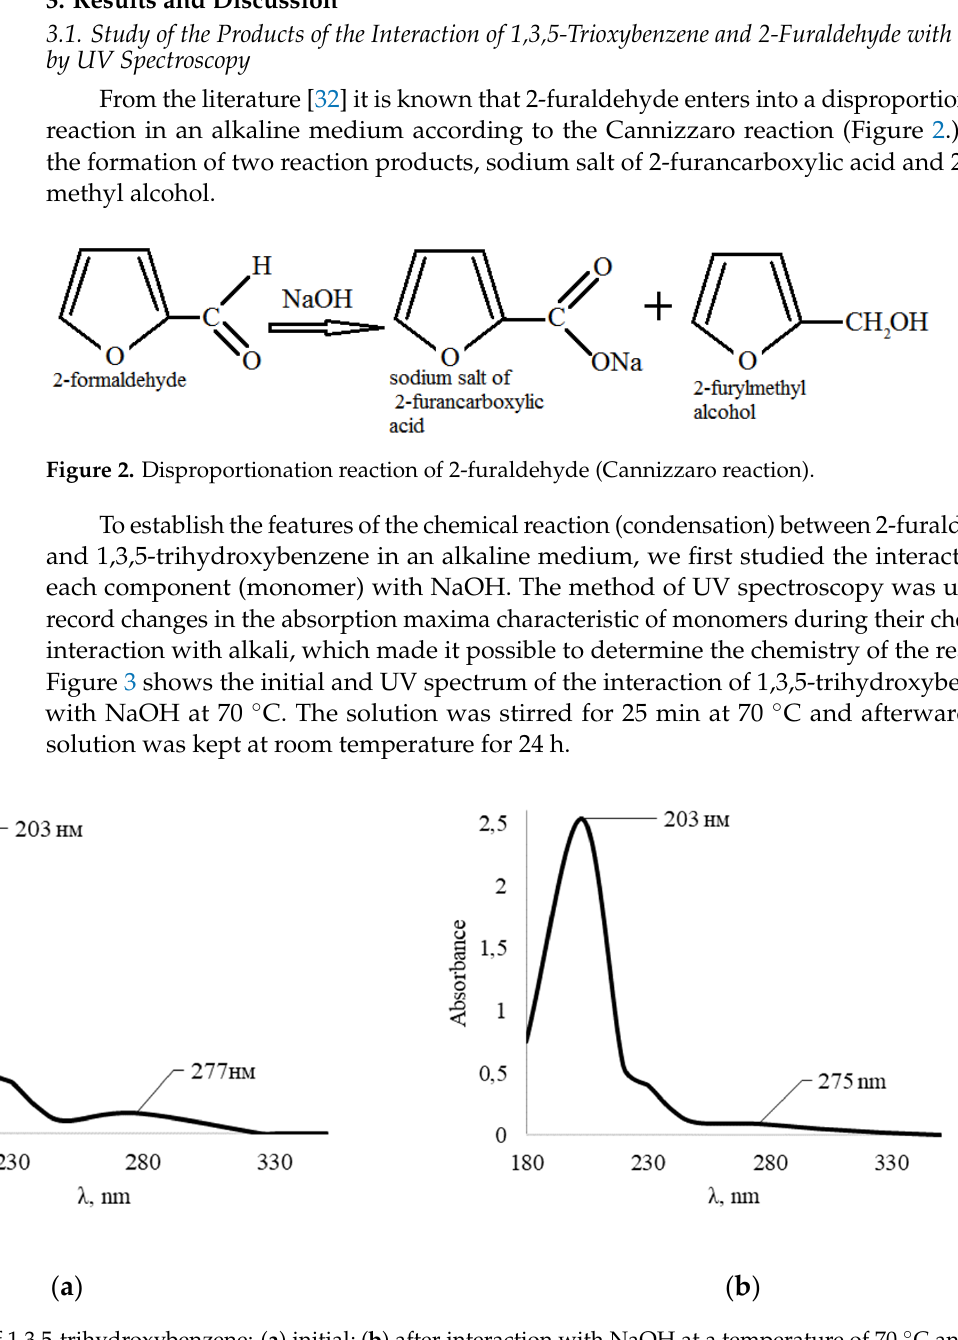
Figure 3. UV spectra of 1,3,5-trihydroxybenzene: ( a ) initial; ( b ) after interaction with NaOH at a temperature of 70 °C and holding for 24 h.